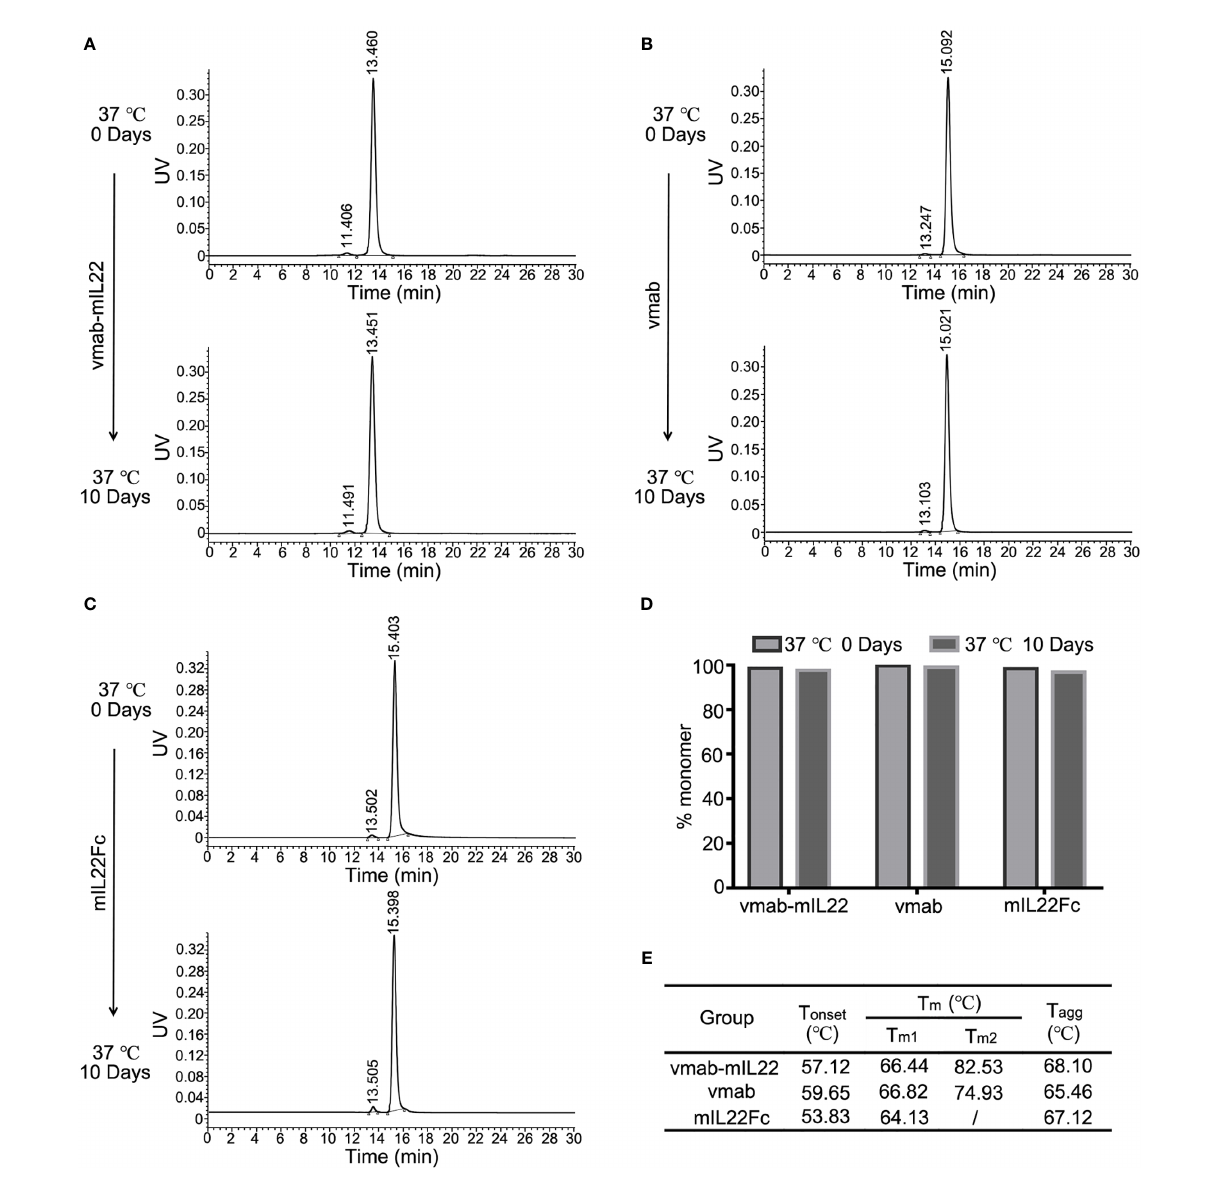
FIGURE 2 | Stability analysis of mIL22-Fc, vmab and vmab-mIL22 at 37°C for 10 days. HPLC-SEC pro fi les of (A) vmab-mIL22, (B) vmab and (C) mIL22Fc at 0°C or 37°C for 10 days. (D) Compared with that observed at the 0 day timepoint, the measurable aggregation (agg) of mIL22-Fc, vmab and vmab-mIL22 did not increase evidently or show measurable degradation after 10 days at 37°C (clip). (E) Thermal stability analysis of vmab-mIL22, vmab and mIL22-Fc using intrinsic protein fl uorescence measurements. The fi nal values were averages of three independent measurements. Increasing Tm and Tagg values re fl ect an increase in macroscopic conformational stability. Tonset (°C), protein unfolding temperature; Tm, melting temperature; Tagg, aggregation